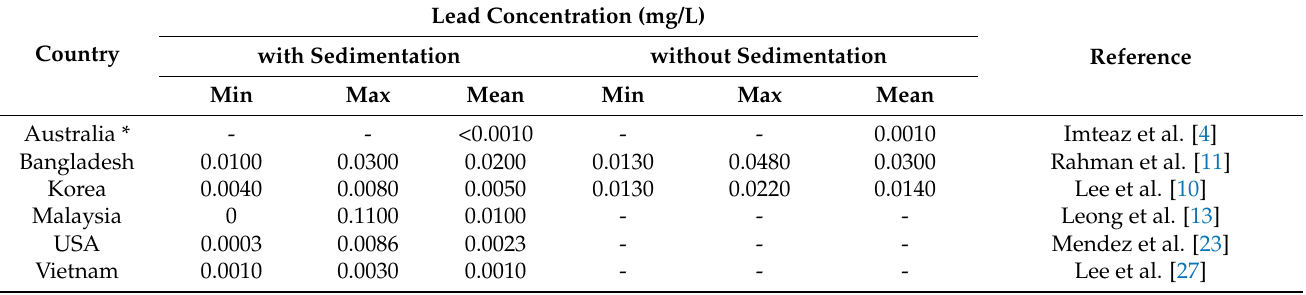
Table 5. Measurements on lead